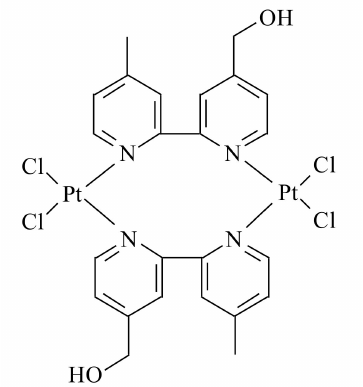
Figure 6. Structure of the hypothesized dimeric specie [Pt(PLLA-Bipy)Cl 2 ] 2